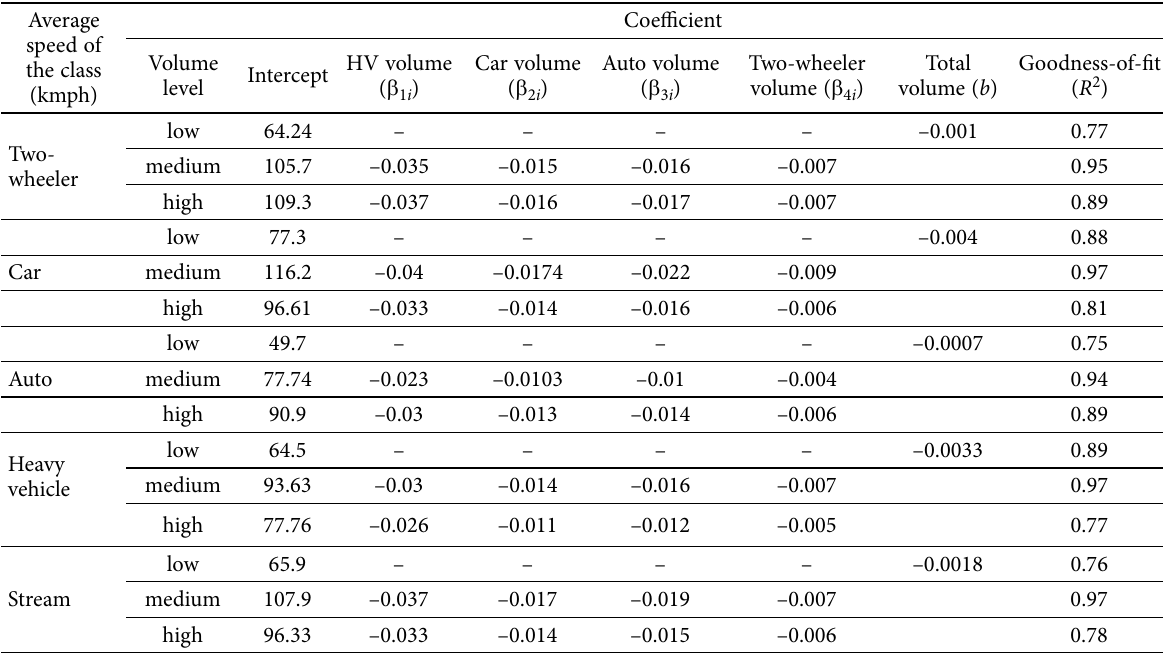
Table 1. Multi-regime multi-class speed